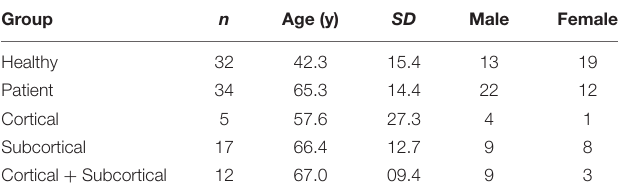
Frontiers in Neuroscience |